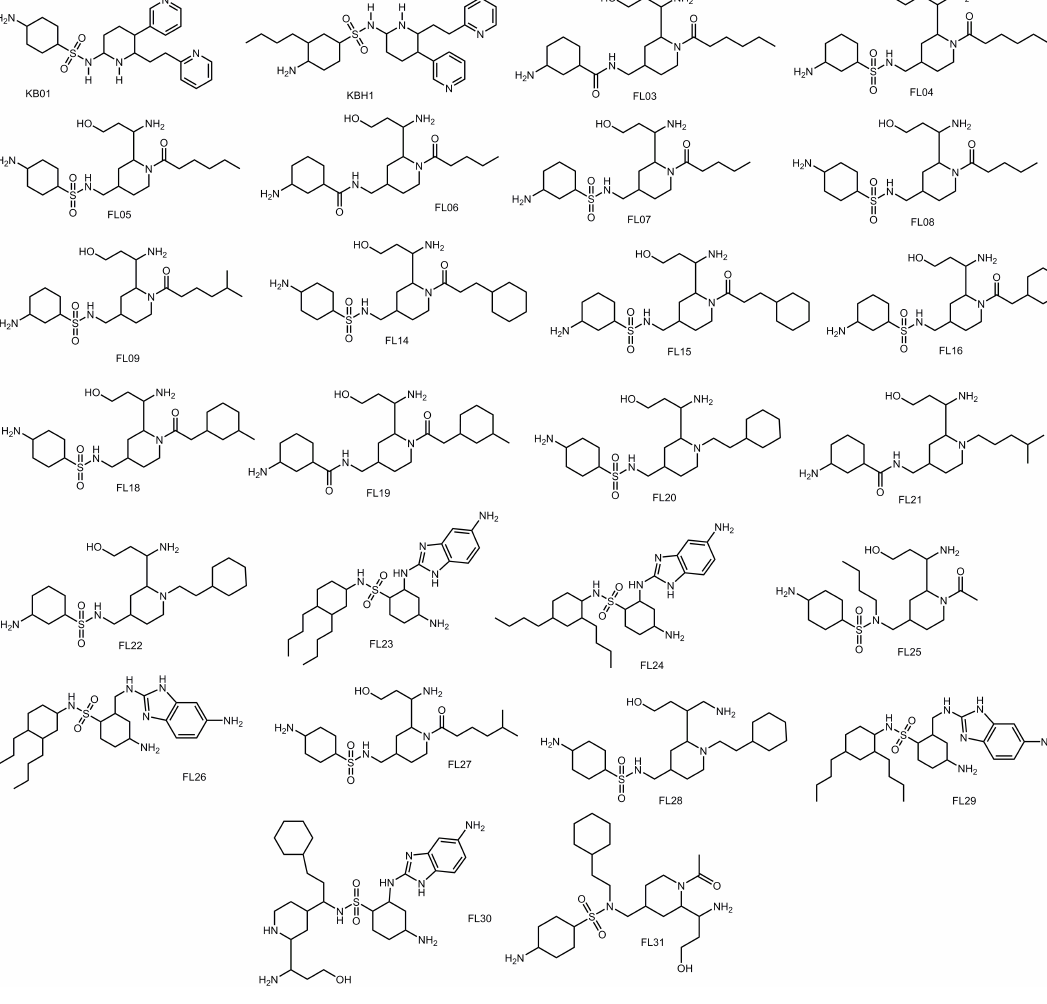
Figure 15. Structures of optimized compounds designed using the guidelines garnered from the molecular docking